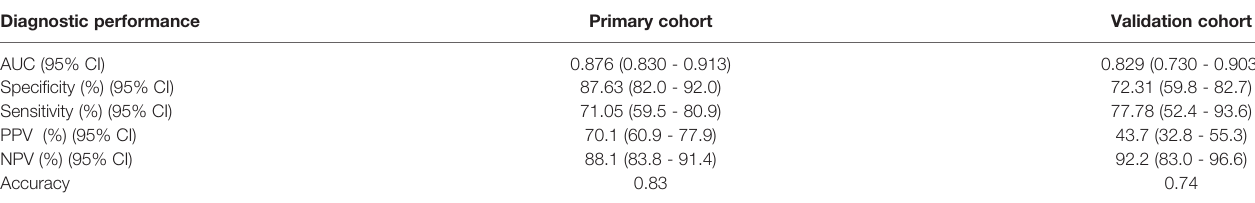
TABLE 3 | Diagnostic performance of the scoring system in primary and validation cohort.